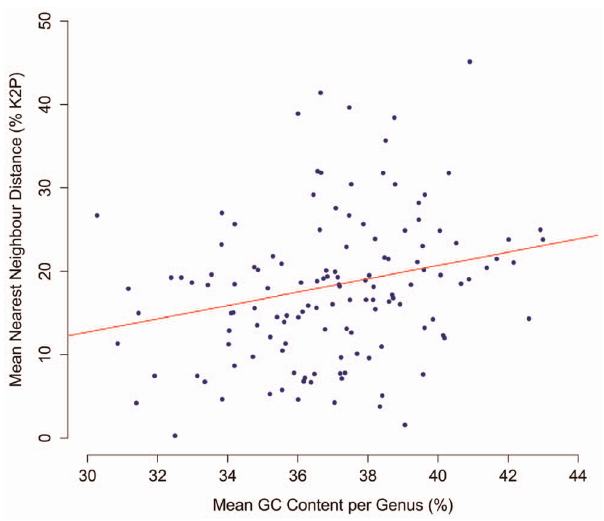
Figure 8. The relationship between GC content and genetic distance across genera. Mean nearest neighbour distance (% K2P) at COI plotted against mean GC content (%) for congeneric species in the 138 genera of molluscs analyzed in this study. The correlation was significant (P , 0.001; R=0.29).